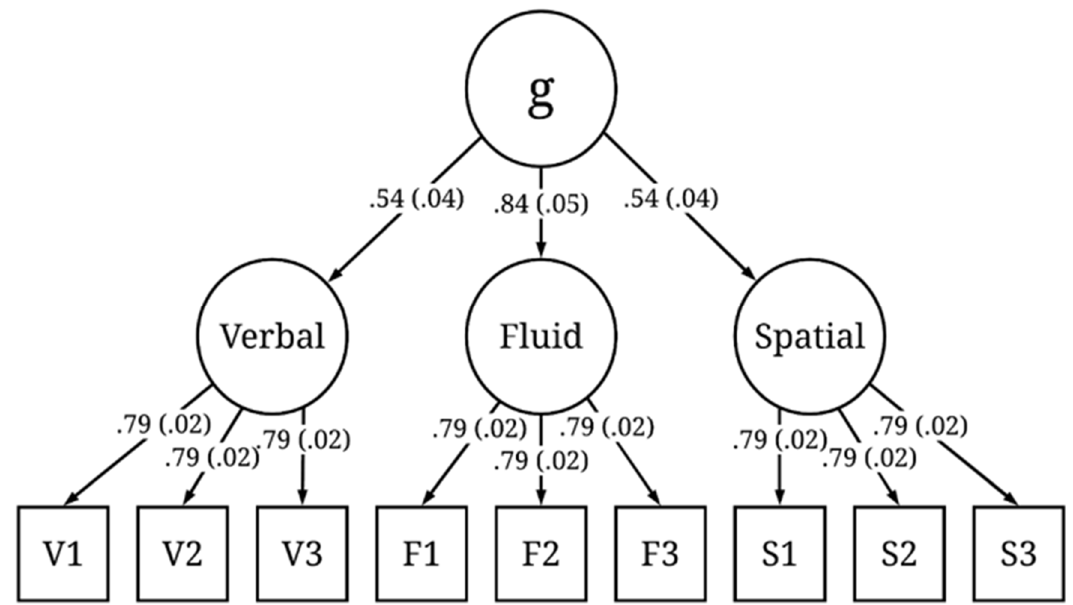
Figure 1. Latent variable model of intelligence based on 200 iterations of simulated test scores. Values represent the mean (and standard deviation) standardized factor loadings.